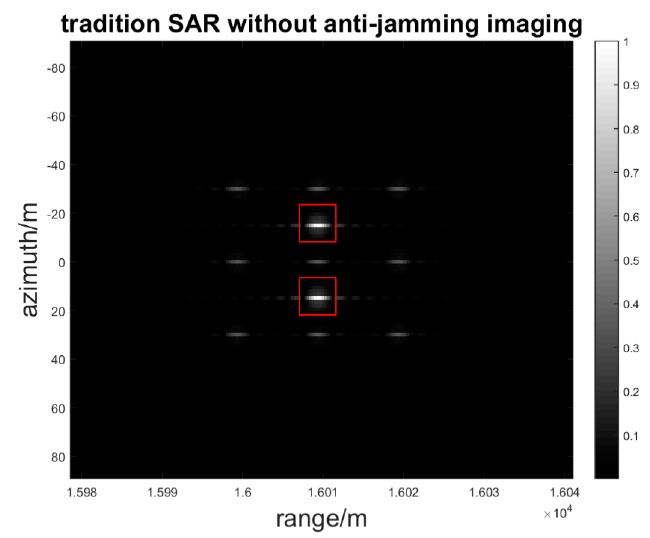
Figure 11. Deception jamming image in traditional SAR.